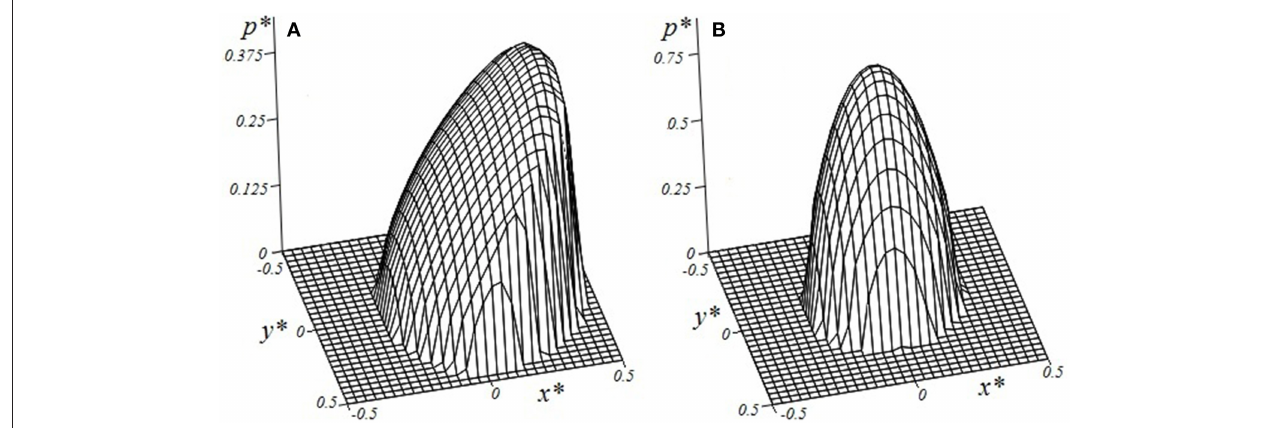
FIGURE 2 | Contact pressure distribution within the contact area ( V ∗ = 1 / 3 (A) , V ∗ = 10 (B) , h ∗ = 0.1, c = 5, ν = 0.3, Q ∗ = 0.15).